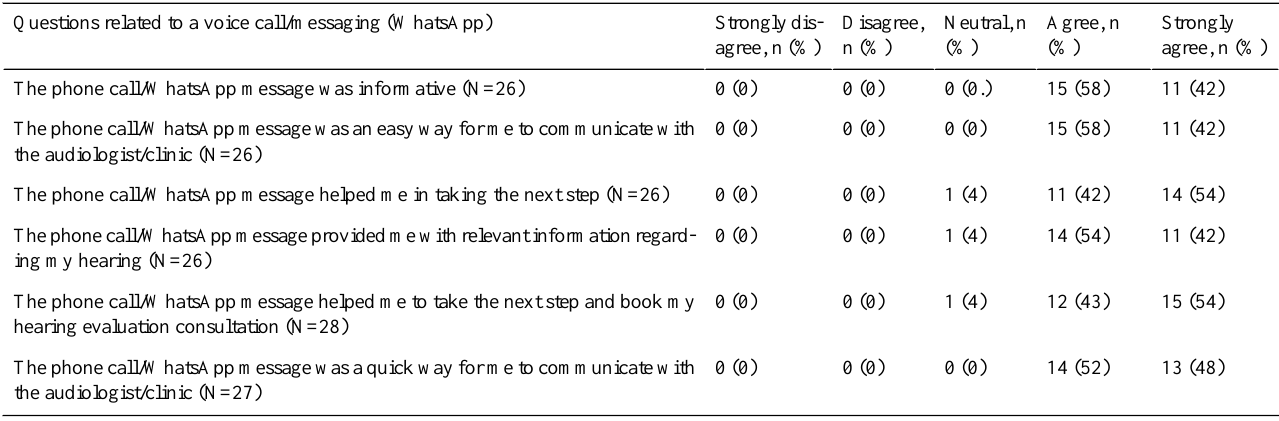
Table 2. Patient evaluation of motivational engagement using a voice call/messaging (WhatsApp).